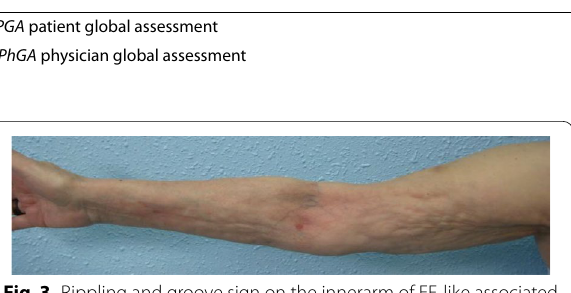
Fig. 3 Rippling and groove sign on the innerarm of EF‑like associated to skin sclerosis